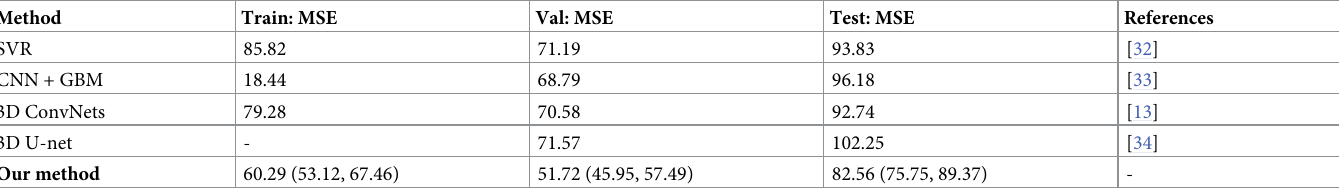
Table 2. The comparison of the MSE values of the proposed method and current state-of-the-art methods.